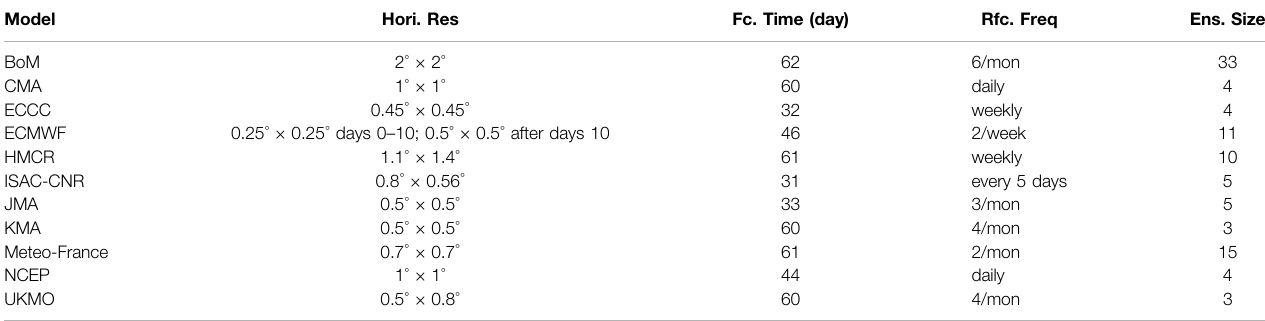
TABLE 1 | Horizontal resolution (Hori. Res.), forecast time (Fc. Time), reforecast frequency (Rfc. Freq.), and ensemble size (Ens. Size) of the 11 sub-seasonal to seasonal (S2S) models (http://www.s2sprediction.net). Model Hori.